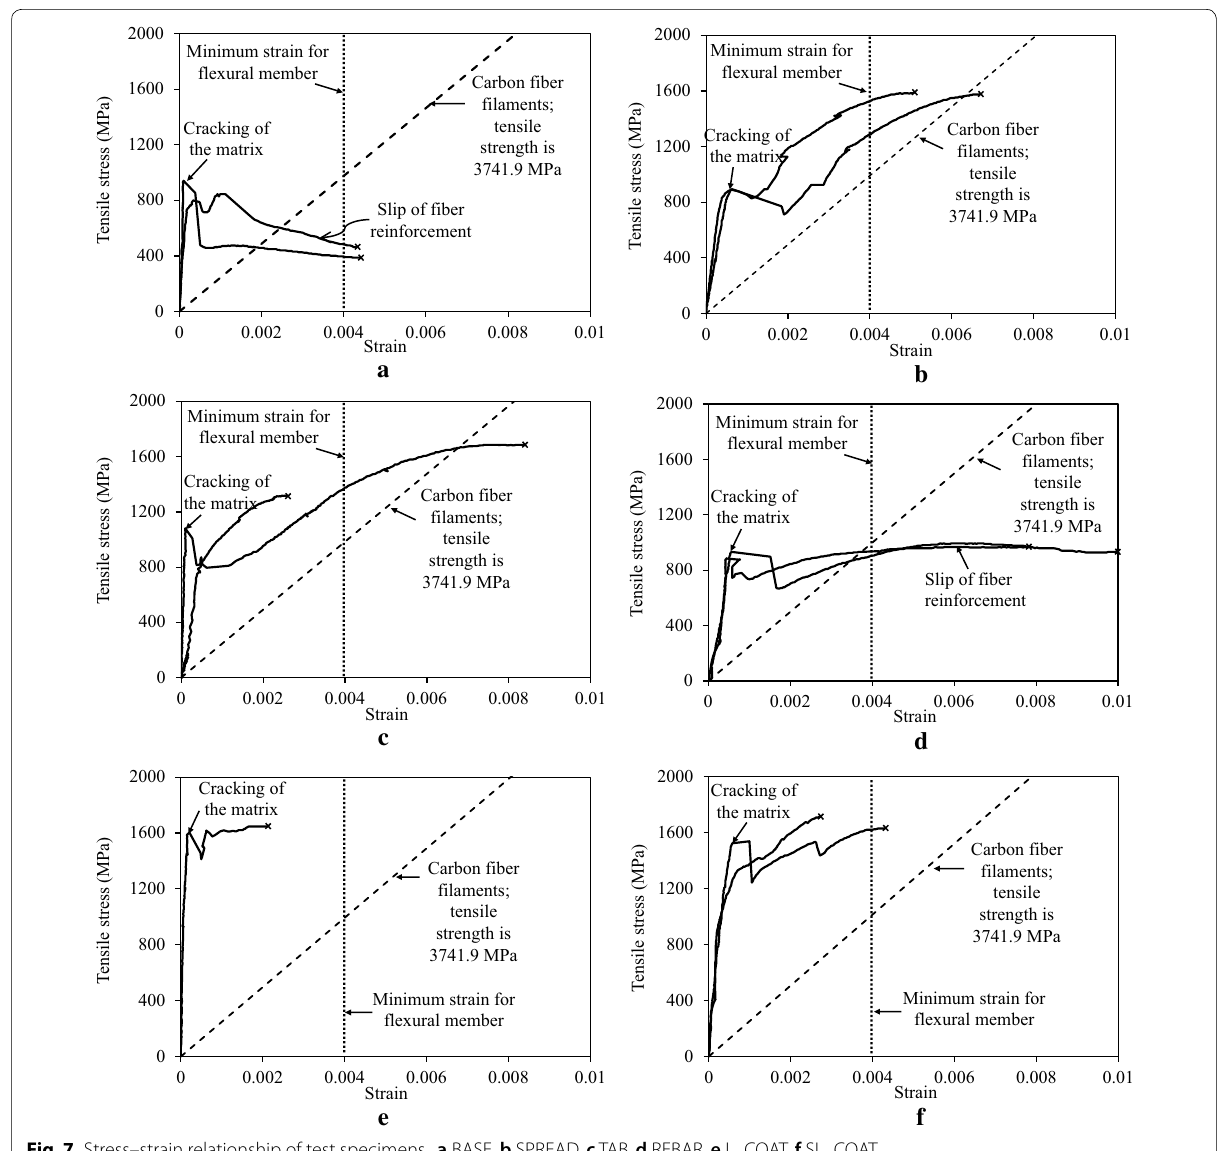
Fig. 7 Stress–strain relationship of test specimens. a BASE, b SPREAD, c TAB, d REBAR, e L_COAT, f